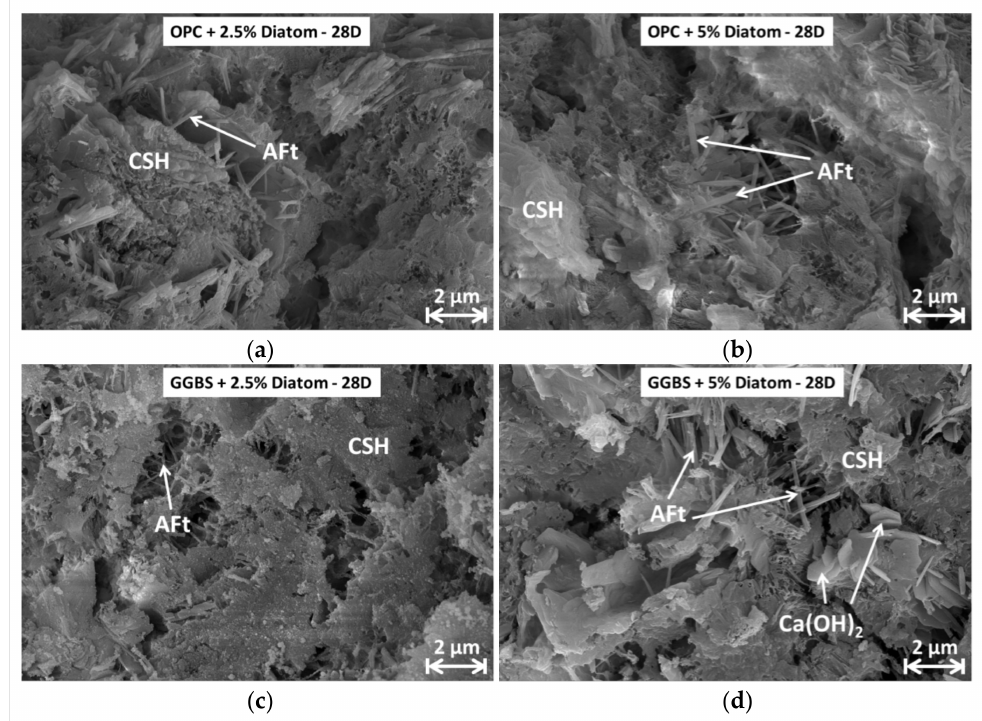
Figure 7. Microstructure observations of different paste samples under SEM at 28D: ( a ) OPC + 2.5% diatom, ( b ) OPC + 5% diatom, ( c ) GGBS + 2.5% diatom, ( d ) GGBS + 5%